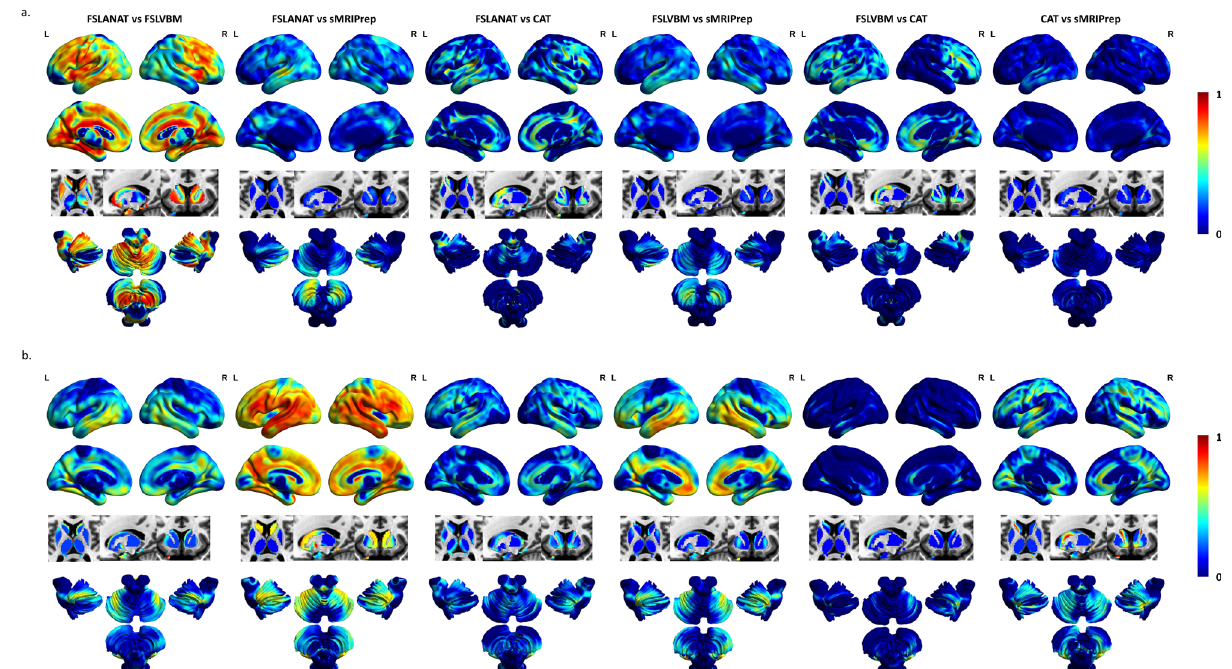
Fig. 2 Voxel-level intraclass correlation coef fi cient (ICC) maps. Voxel-level intraclass correlation coef fi cient (ICC) maps between pipelines of a dataset 1 and b dataset 2. L left, R right. The color grading re fl ects the ICC value.